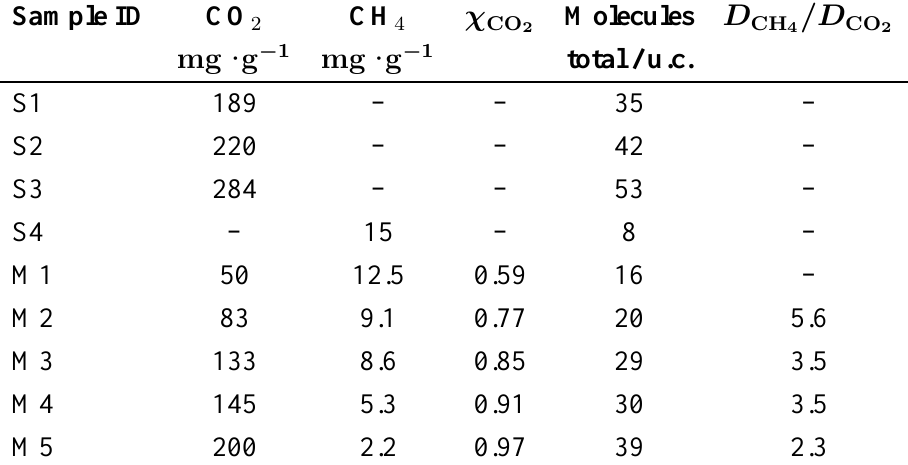
Table 2. Single-component (S) and mixture (M) adsorption samples prepared for NMR studies on CuBTC: CO and CH loadings, molar fraction of adsorbed CO 2 4 total number of molecules per unit cell (u.c.) and ratio of NMR measured self-diffusion coefficients ( D CH 4 /D CO 2